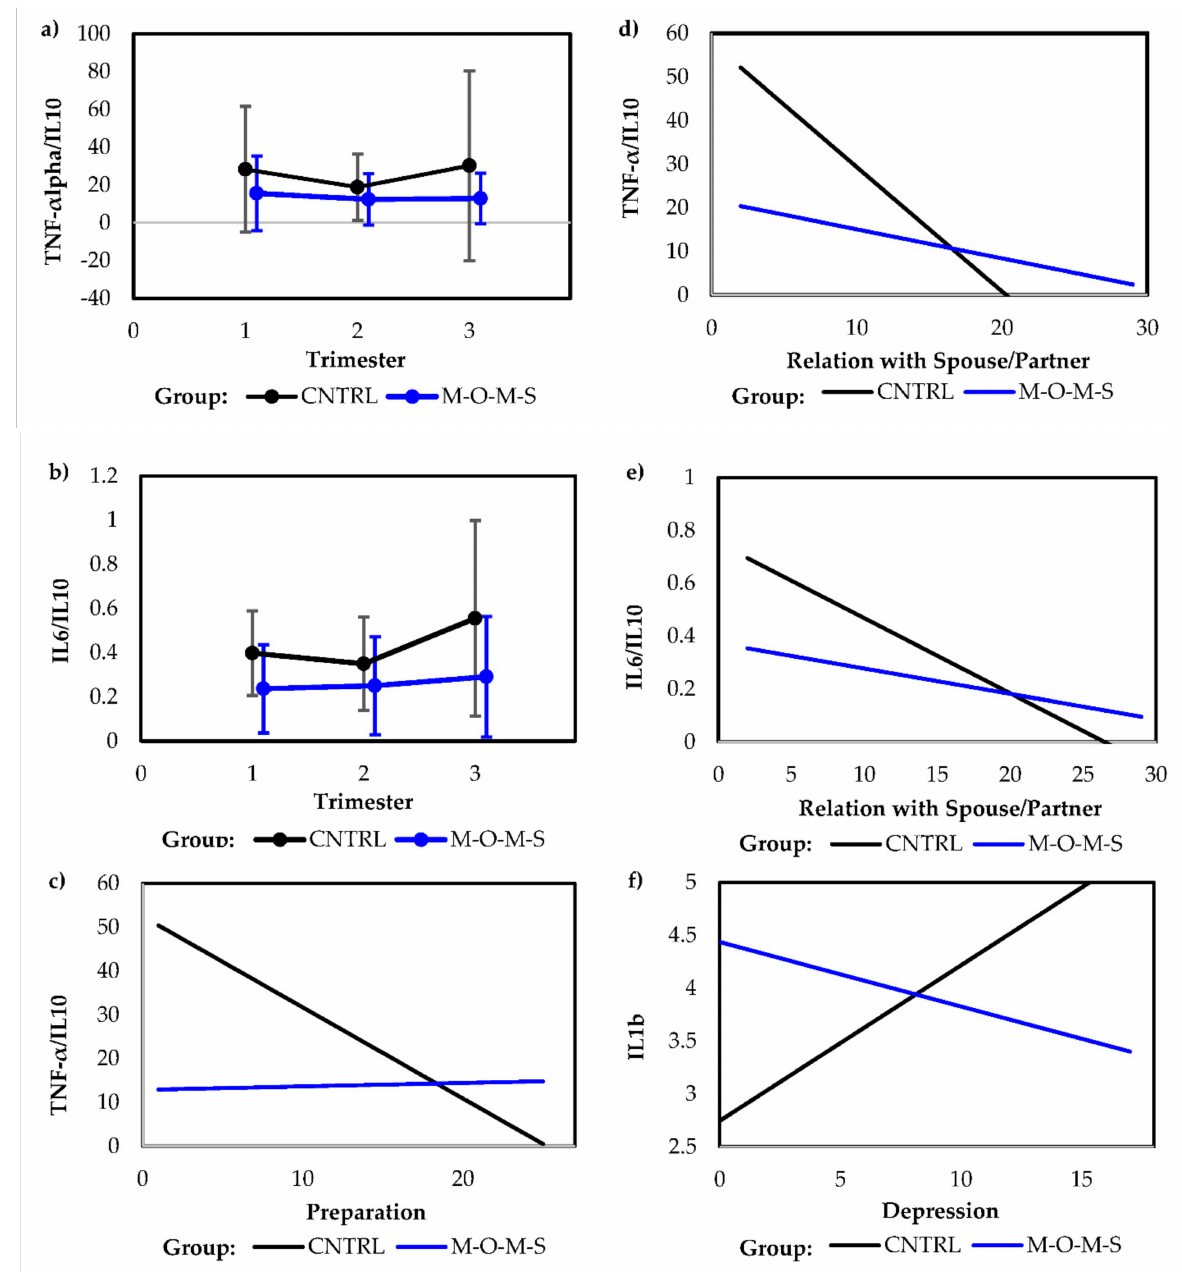
Figure 1. ( a ) Longitudinal comparison of TNF-alpha/IL-10 ratio for M-O-M-S TM intervention and control groups. ( b ) Lon- gitudinal comparison of IL-6/IL-10 ratio for M-O-M-S TM intervention and control groups. ( c ) Longitudinal relationship between TNF- α /IL-10 ratio to reparation for Labor anxiety for M-O-M-S TM intervention and control groups. ( d ) Longitu- dinal relationship between TNF- α /IL-10 ratio to Relationship with Spouse/Partner anxiety for M-O-M-S TM intervention and control groups. ( e ) Longitudinal relationship between IL-6/IL-10 ratio to Relationship with Spouse/Partner anxiety for M-O-M-S TM intervention and control groups. ( f ) Longitudinal relationship between IL1 β to depressive symptoms for M-O-M-S TM intervention and control